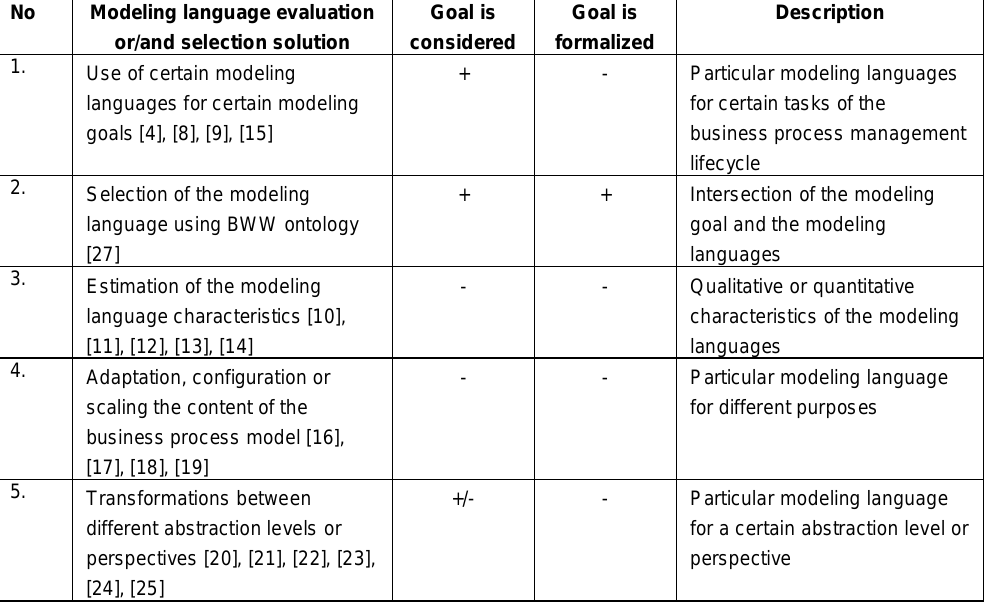
Table 1. The solutions for business process modeling language selection and/or evaluation